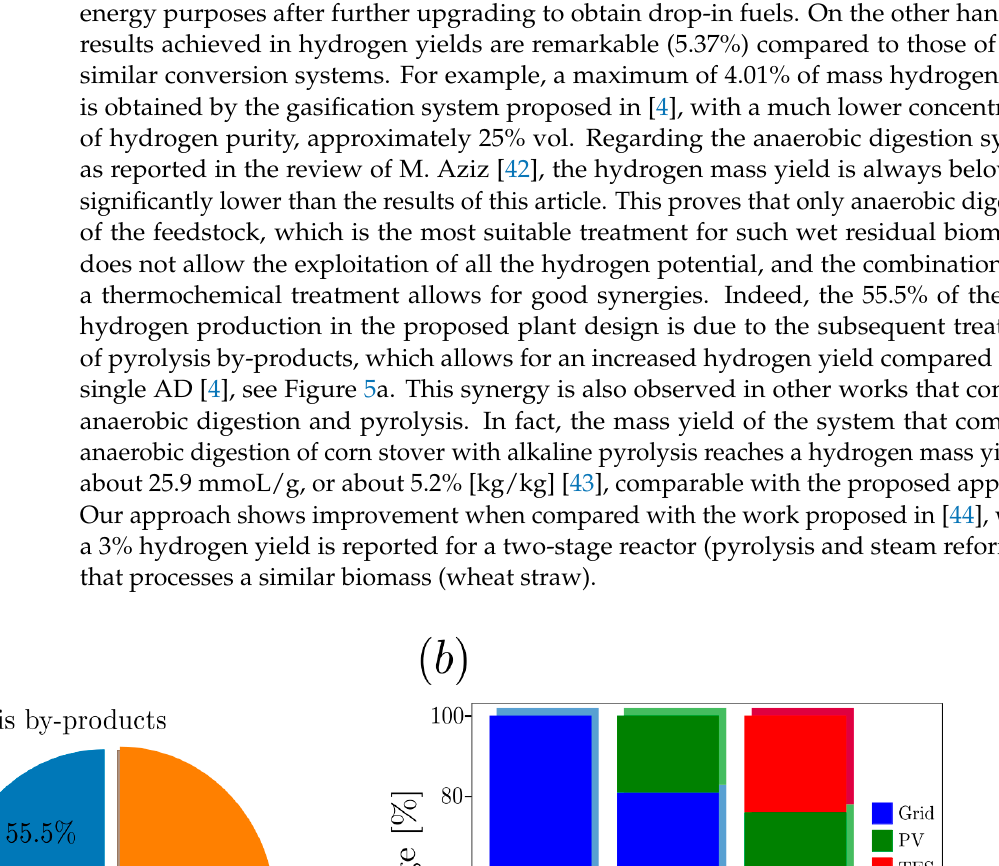
Table 5. KPIs of the plant-dependent from the scenarios analyzed . Performance Parameters